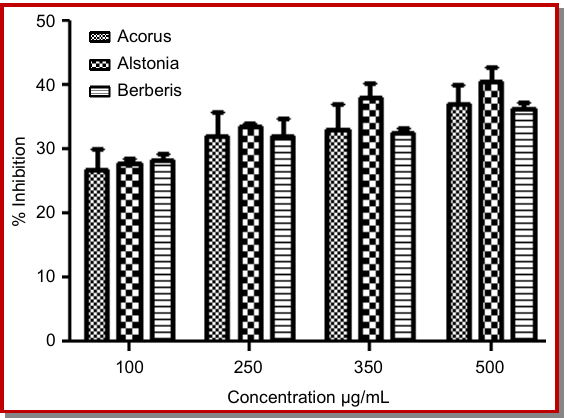
Figure 1: Percentage inhibition of L. donovani promastigotes in the presence of methanolic leaf extracts of Acorus calamus , Al- stonia scholaris and Berberis aristata (100-500 μ g/mL). Each data value represents mean ± SEM of at least three experiments